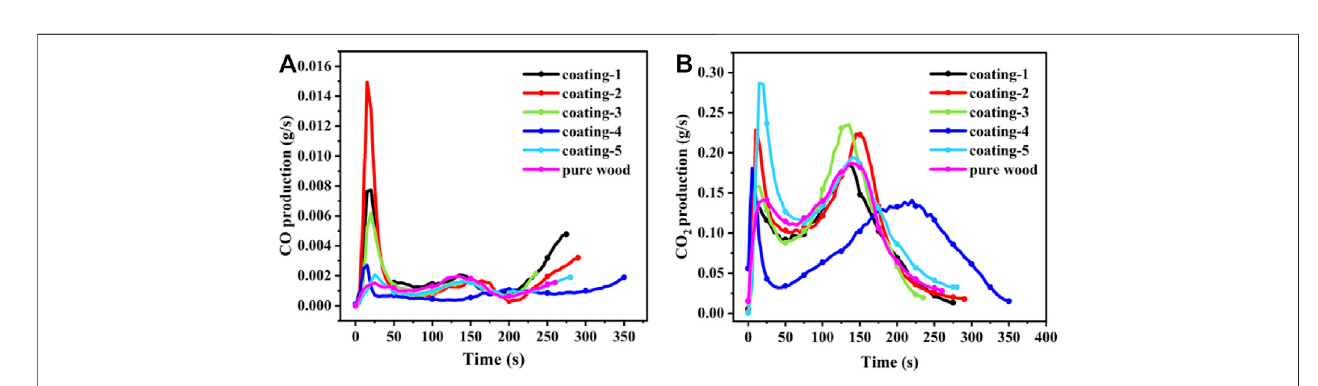
Figure 6 . From the curves of CO 2 production, it is found the curves have the same trend as the HRR curves. Both the CO 2 production curves and the HRR curves include two stages due to the combustion of cellulose, hemicellulose, and lignin and the further combustion of small molecules. The wood with coating-4 showed the best effect on the delay and reduction of CO 2 production. However, the CO production curves are different. From Figure 6 , the CO production of pure wood is much lower than the CO 2 production due to most of the CO can be transferred into CO 2 at a high heat fl ux (35 kW/m 2 ).